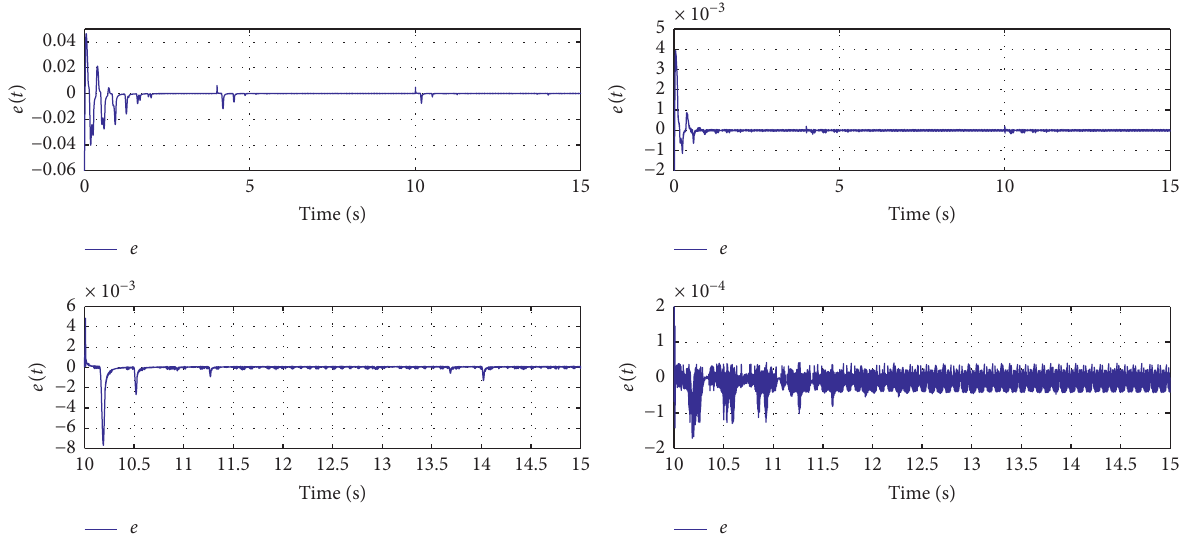
Figure 14: Tracking error of NN-FOSM and NN-FFOSM in case